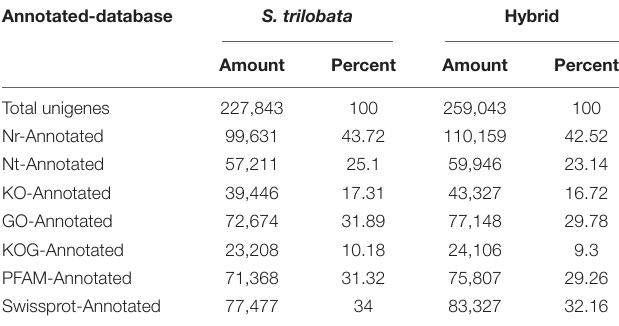
TABLE 2 | Functional annotation of unigenes from two species.